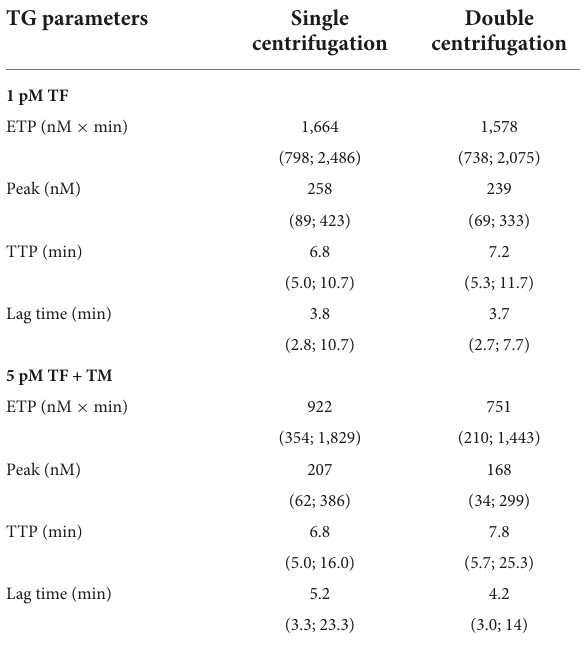
TABLE 2 Median values and ranges of thrombin generation studies–single vs. double centrifugation scheme to prepare plasma